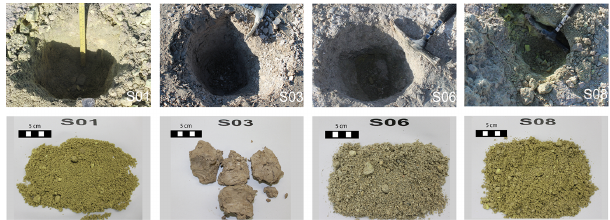
Fig. 6. (upper row) Digital pictures of the pits where soil samples were collected and (lower row) corresponding material. The dif- ference between granular and cohesive types can be distinguished visually. S01 is loose and shows few clasts ≥ 1cm dispersed in an ∼ uniform fine sand matrix. S03 occurs in blocks of cohesive mate- rial and no particle can be distinguished. S06 is loose and shows few clasts ≥ 1cm, but the matrix is graded. S08 has few clasts ≥ 1cm and appears graded. S01 and S06 also have sulfur grains, as indi- cated by the yellowish